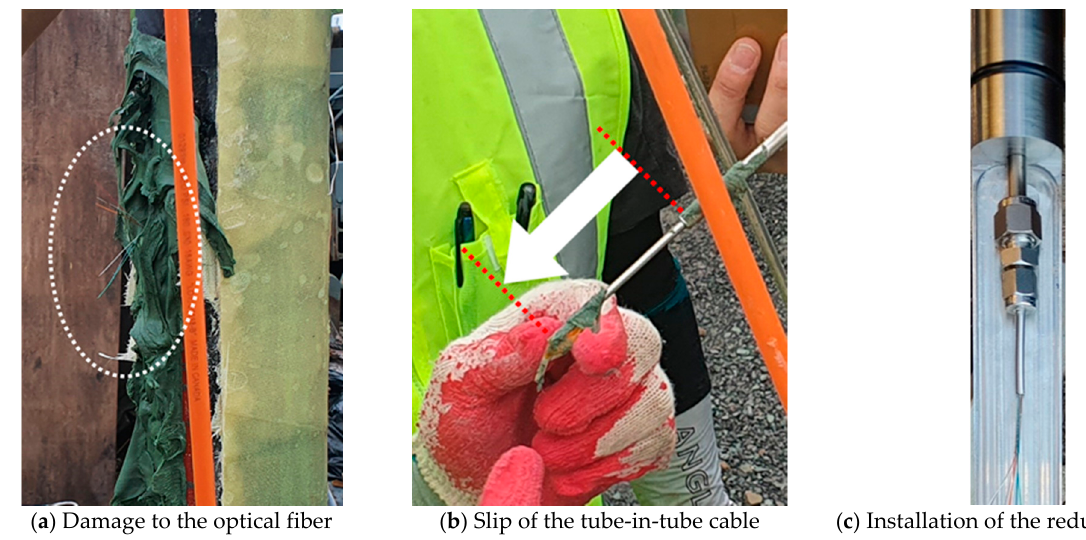
Figure 12. The damage to the optical fiber attributed to the slip of the tube-in-tube optical fiber cable: ( a ) Damage to the optical fiber; ( b ) Slip of the tube-in-tube optical fiber cable; ( c ) The optical fiber cable with the reducing union installed.